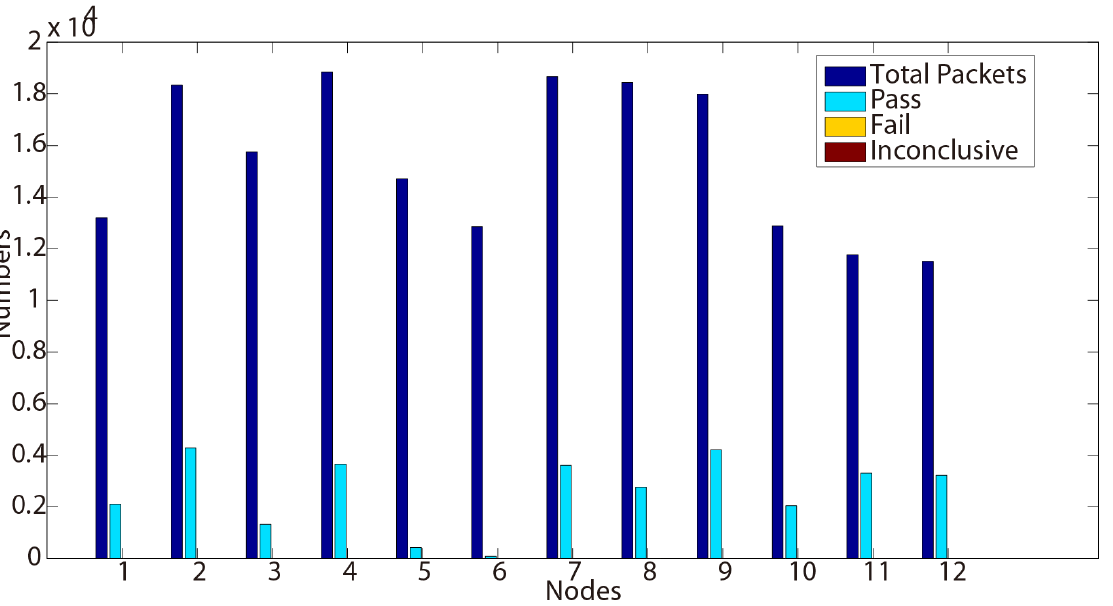
Figure 5. Test results for Property 3 (Day